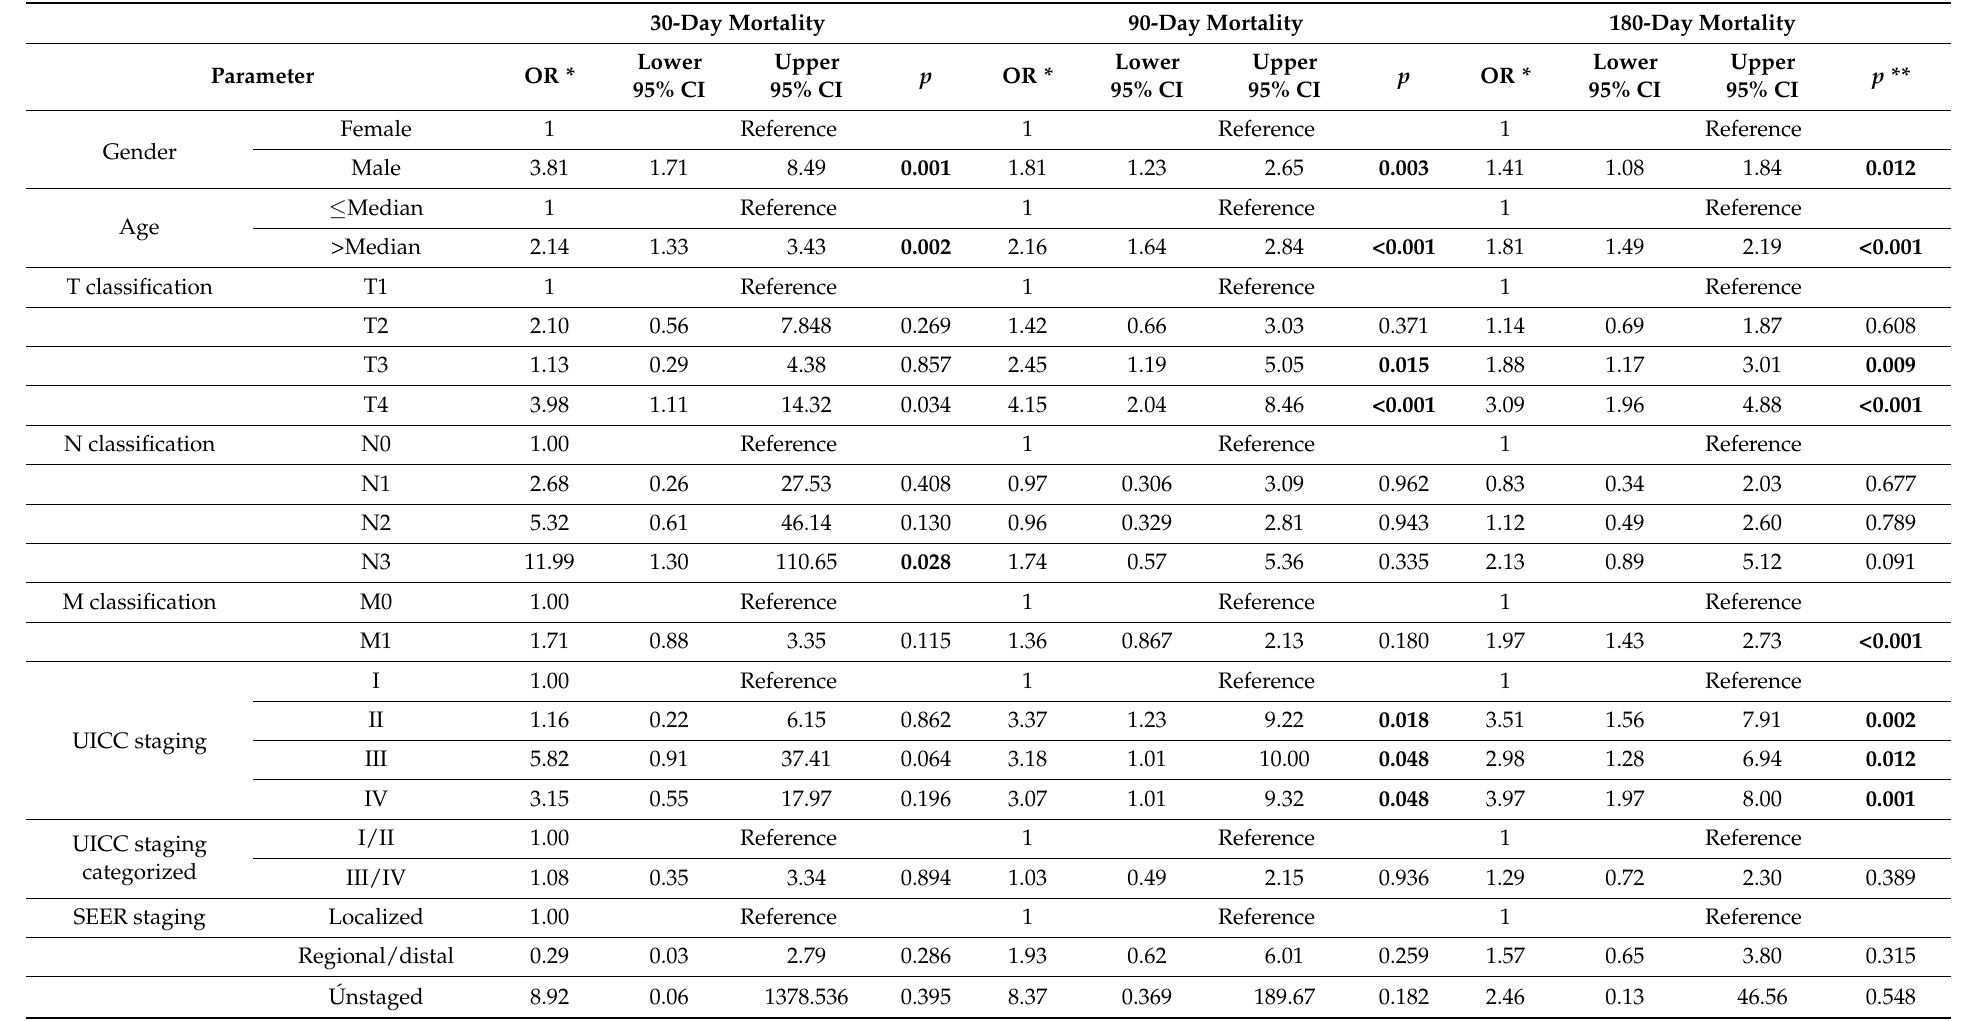
Table 2. Multivariate analyses on predictors for 30-day, 90-day, and 180-day